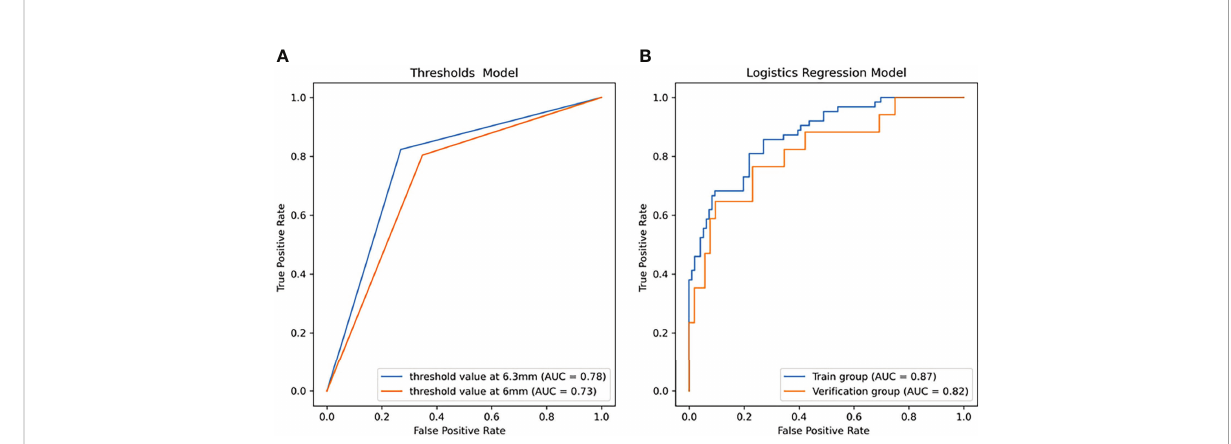
FIGURE 4 The receiver operator characteristic (ROC) curves of the linear models for predicting the growth of the nodules within one year. (A) ROC curve of the threshold prediction model (area under the ROC curve (AUC) = 0.73 as threshold at 6 mm, AUC = 0.77 as threshold at 6.3 mm). (B) ROC curve of logistic regression (LR) (AUC = 0.87 in the training group, AUC =0.82 in the validation